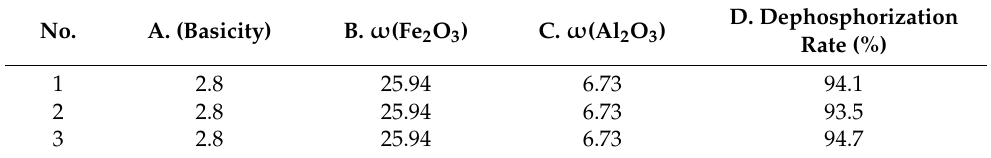
Table 7. Optimization experimental